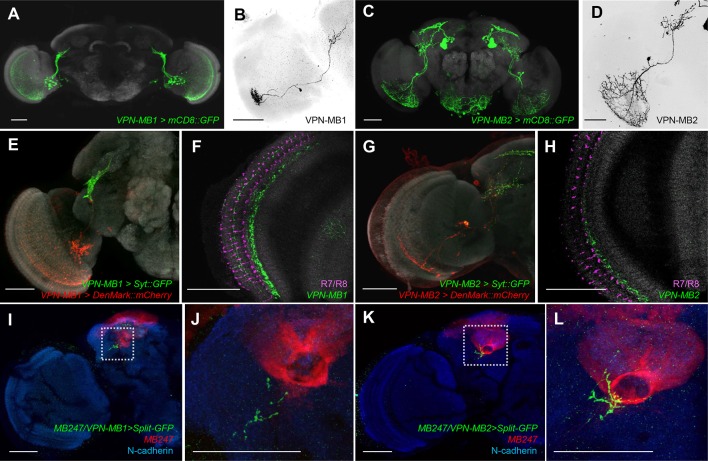
VPNs directly convey optic lobe inputs to the MB vAC.(A) VPN-MB1 neurons labeled by MB425B-GAL4. (B) A single VPN-MB1 neuron, generated by heat shock flip out, connects the medulla and the central brain. (C) VPN-MB2 neurons labeled by MB334C-GAL4. (D) VPN-MB2 neurons connect the medulla and the central brain. (E) VPN-MB1 has dendrites (DenMark::mCherry, red) in the ventral medulla and presynaptic terminals in the central brain (Syt::GFP, green). (F) The dendrites of VPN-MB1 (green) arborize in the M8 layer. (G) VPN-MB2 has dendrites (DenMark::mCherry, red) in the ventral medulla and presynaptic terminals in the central brain (Syt::GFP, green). (H) The dendrites of VPN-MB2 (green) arborize in the M7 layer. (I–J) Reconstituted GFP signals visualize contacts between KCs and VPN-MB1 in the vAC. (K–L) Reconstituted GFP signals visualize contacts between KCs and VPN-MB2 in the vAC. J and L are magnifications of the insets in I and K. Scale bars represent 50 µm.